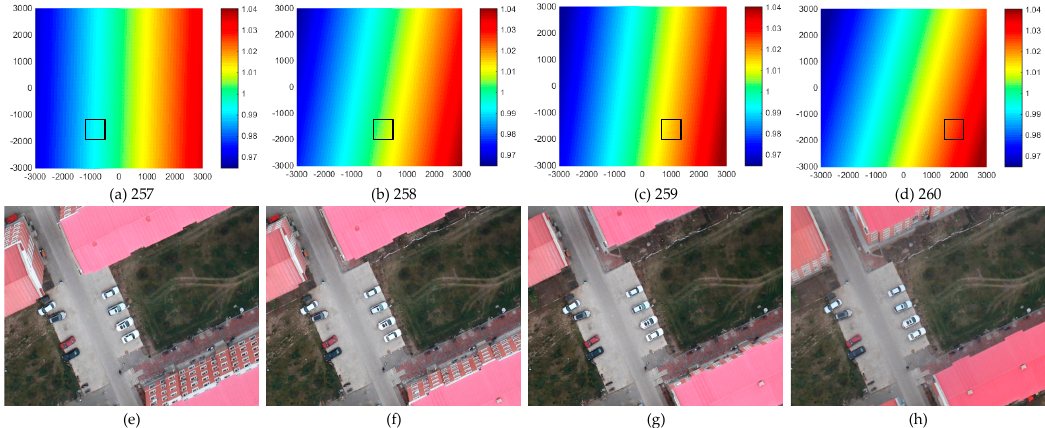
Figure 10. Typical continuous images and schematic diagram of GSD distribution with different ω and ϕ angles of Baoding. ( a ) Schematic diagram of GSD distribution for image “257” with the angle ω and ϕ are 2.3 ˝ and 0.1 ˝ ; ( b ) image “258” with angle 2.2 ˝ and 0.4 ˝ ; ( c ) 2.4 ˝ and 0.3 ˝ for image “259”; ( d ) 2.2 ˝ and 0.6 ˝ for image “260”; ( e ) partially view of image “257”; ( f ) “258”; ( g ) “259”; ( h ) “260”.